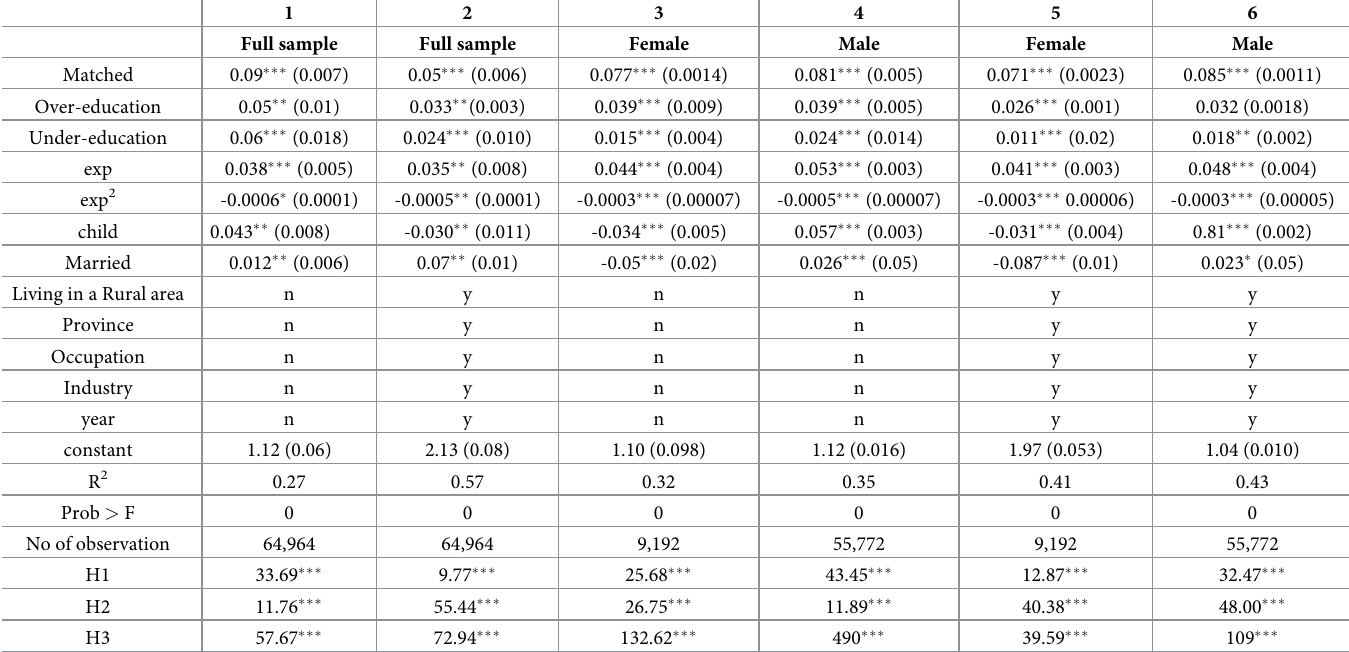
Table 6. Return to under, required, and over education.